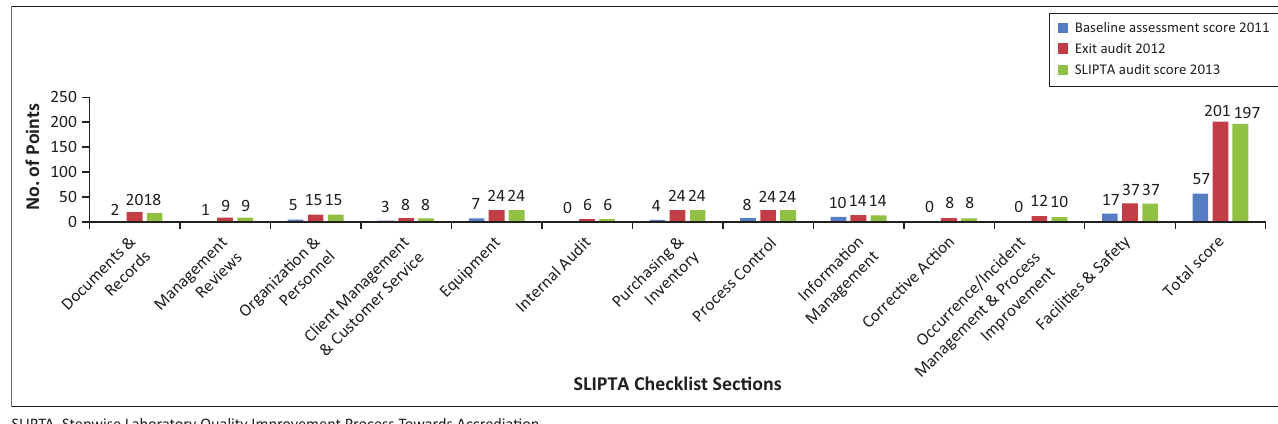
FIGURE 3: Percentage scores for National Tuberculosis Reference Laboratory performance in each section of the Stepwise Laboratory Quality Improvement Process Towards Accreditation checklist at baseline, exit and final Strengthening Laboratory Management Toward Accreditation audits.